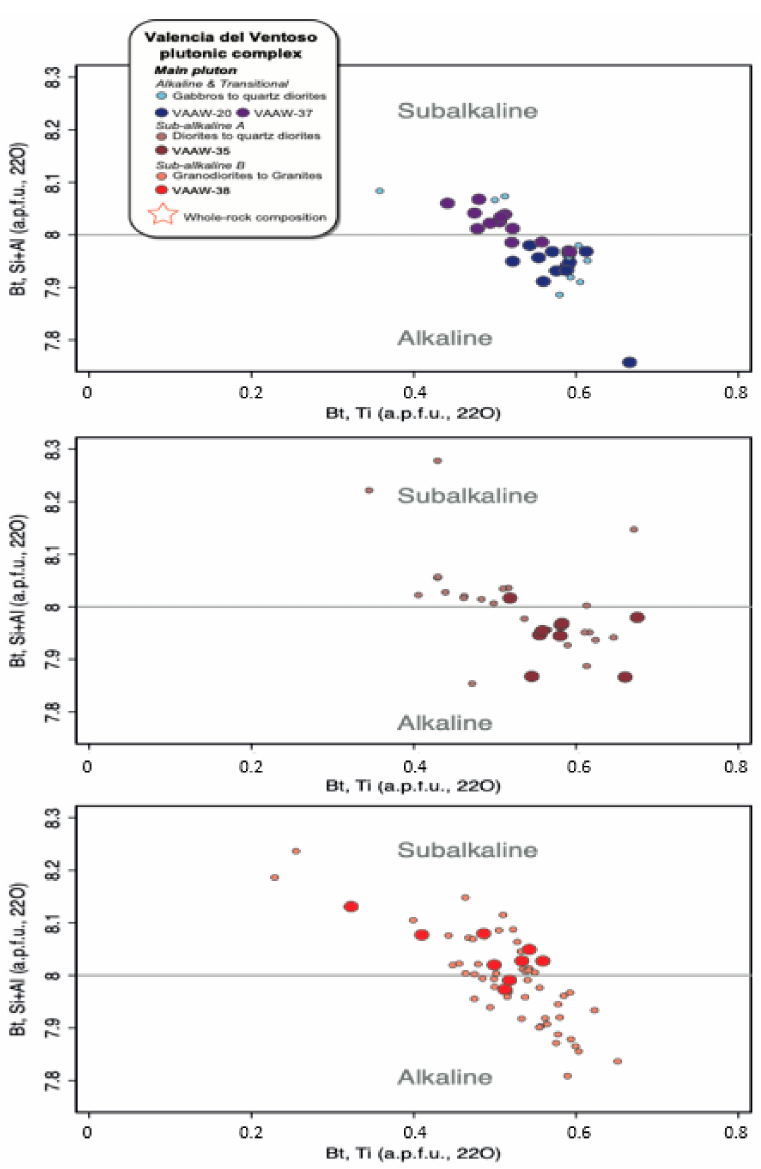
Figure 4. Composition of biotite from the inner, intermediate, and border facies rocks from the Valen- cia del Ventoso main pluton. Alkaline and subalkaline fields as indicated in [5,50]. Compositional data of biotite from [44] (smaller lighter symbols) are shown for